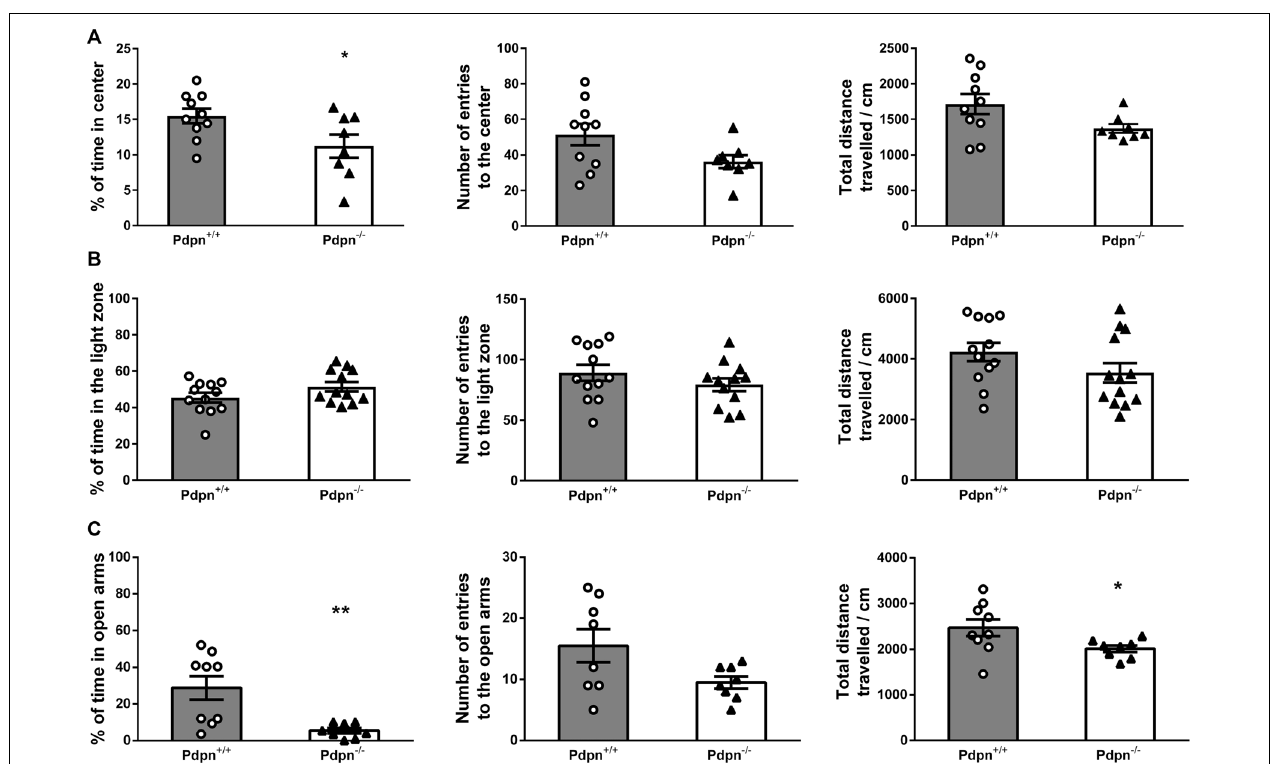
FIGURE 3 | Effects of podoplanin deletion on anxiety-like behavior. Anxiety-like behavior was evaluated using several tests. (A) In Open Field test (OFT) significant difference in percentage of time spent in the brightly lit center between Pdpn − / − and their wild-type littermate was found ( t ( 16 ) = 2.29, ∗ P = 0.04, n = 8–10). No significant differences were observed in total distance traveled and the number of entries to the brightly lit center ( t ( 16 ) = 2.05, P = 0.06, n = 8–10 and t ( 16 ) = 1.99, P = 0.07, n = 8–10). (B) No differences were observed in the percentage of time spent in the light area of the Light/Dark Box test (LDB) arena ( t ( 22 ) = 1.61, P = 0.2, n = 12). Mice from both groups also showed comparable values for the total distances traveled and the number of entries to the LDB arena ( t ( 23 ) = 1.54, P = 0.2, n = 12–13 and t ( 22 ) = 1.16, P = 0.3, n = 12). (C) Pdpn − / − animals presented with significantly less time spent in the open arms of the elevated plus-maze ( t ( 15 ) = 3.37, ∗∗ P = 0.005, n = 8–9) and significantly less traveled distance in the open arms ( t ( 15 ) = 2.16, ∗ P = 0.05, n = 8–9), as compared to their wild type littermates. No significant differences between groups were observed in the number of entries to the open arms ( t ( 14 ) = 2.08, P = 0.06, n = 8). Data are displayed as mean ±